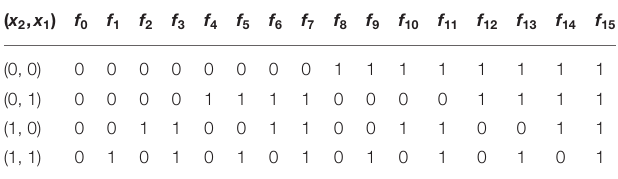
TABLE 2 | Every possible binary Boolean function (a.k.a logical